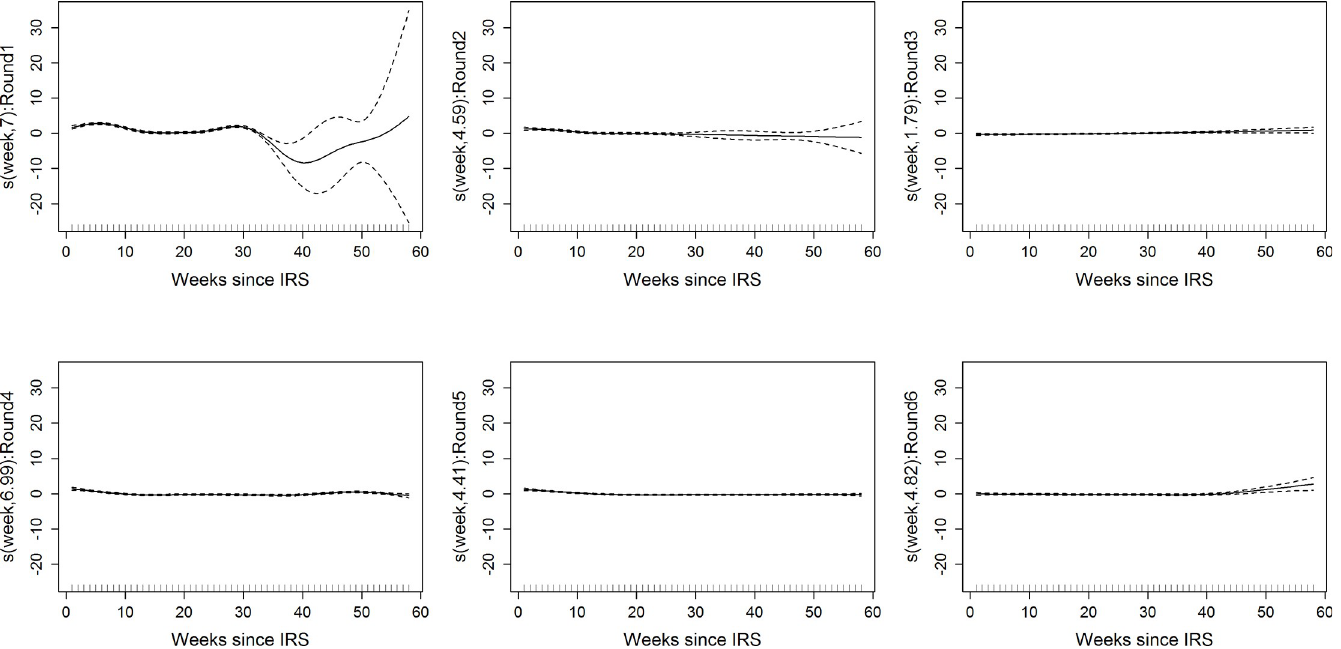
Fig 2. Diagnostic plots showing residuals for the fitted B-splines with 95% credible regions (dotted lines) verses time (in weeks) after each round of bendiocarb (top row) and pirimiphos methyl (bottom row) insecticides using different degrees of freedom (in brackets on the y-axis). A straight horizontal line through point 0 on the y- axis implies better